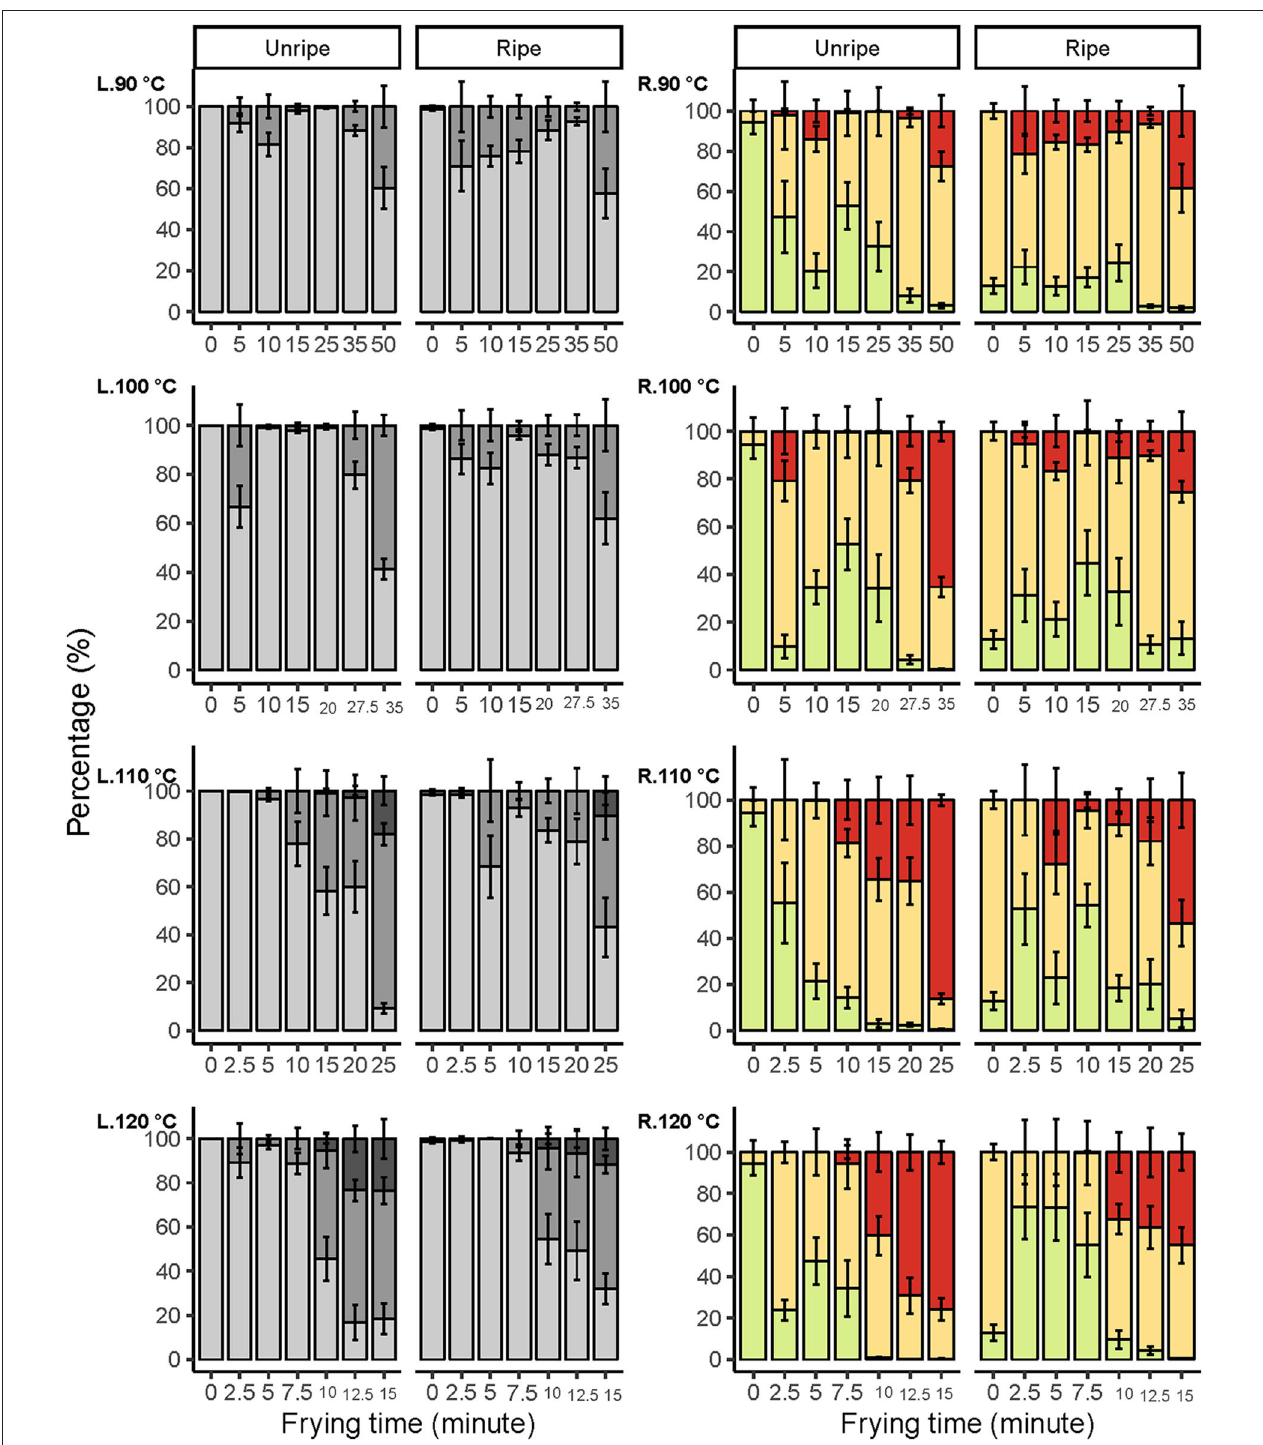
FIGURE 3 | Color distribution in terms of lightness L * (L) and green to red a * (R) changes during vacuum frying at different ripening stages of mango, fried at 90, 100, 110, and 120 ◦ C. Lightness levels of mango were represented in three levels: 0 ≤ dark ≤ 60, 60 < medium-light ≤ 80, 80 < light ≤ 100. Meanwhile, red to green were represented in three levels; green ≤ 0, 0 < medium-red ≤ 10, red > 10. Error bars are standard error N = 8.